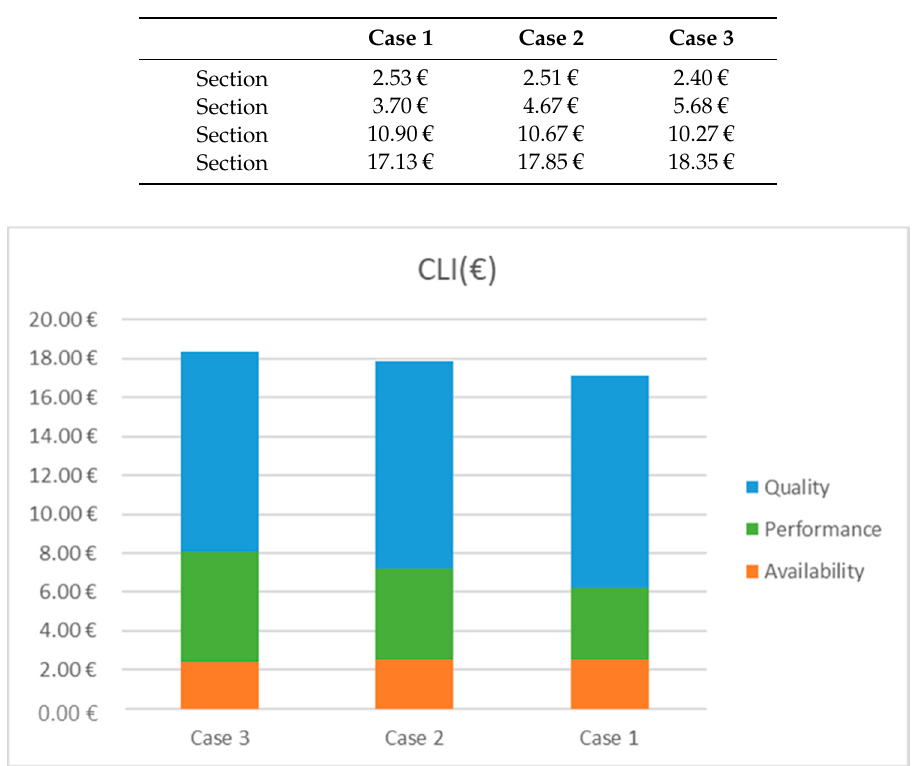
Figure 6. Stacked bar chart for the three tests.